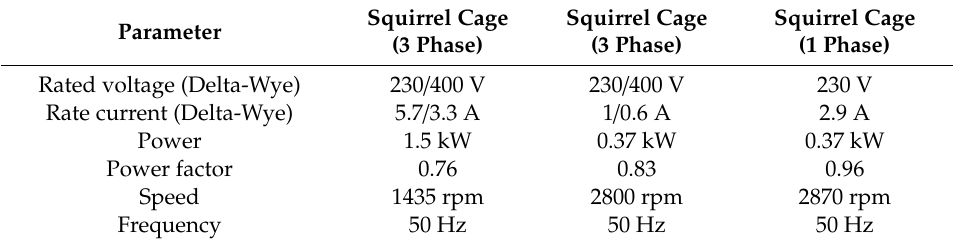
Table 3. Machine characteristics.